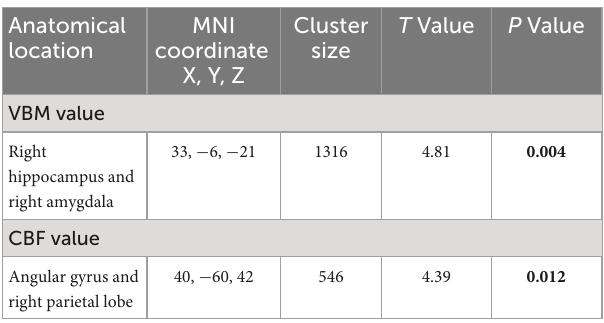
TABLE 2 Difference of VBM and CBF values between AD and